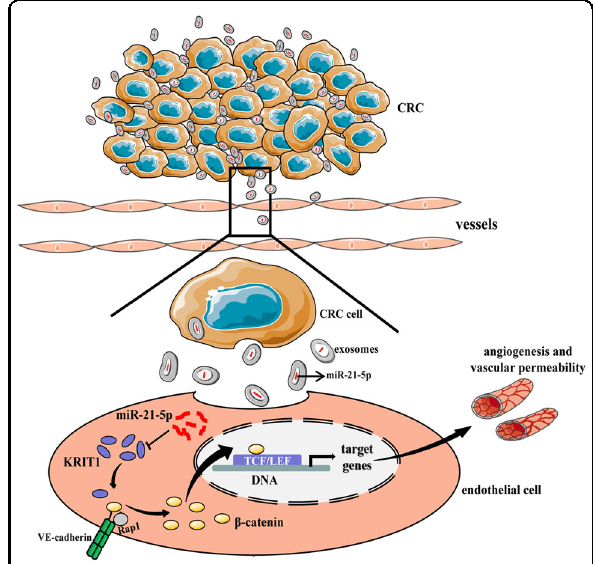
Fig. 6 Schematic diagram of the role of exosomal miR-21-5p secreted by CRC in angiogenesis and vascular permeability. Endothelial cells uptake exosomes secreted by CRC cells, leading to an increase of miR-21-5p expression in recipient cells. Then miR-21-5p directly suppresses KRIT1 expression in recipient endothelial cells, subsequently releases β -catenin from VE-cadherin (a protein mediates adherens junctions of endothelial cells) to nuclear, following by TCF/ LEF dependent transcription, consequently induces angiogenesis and vascular permeability in